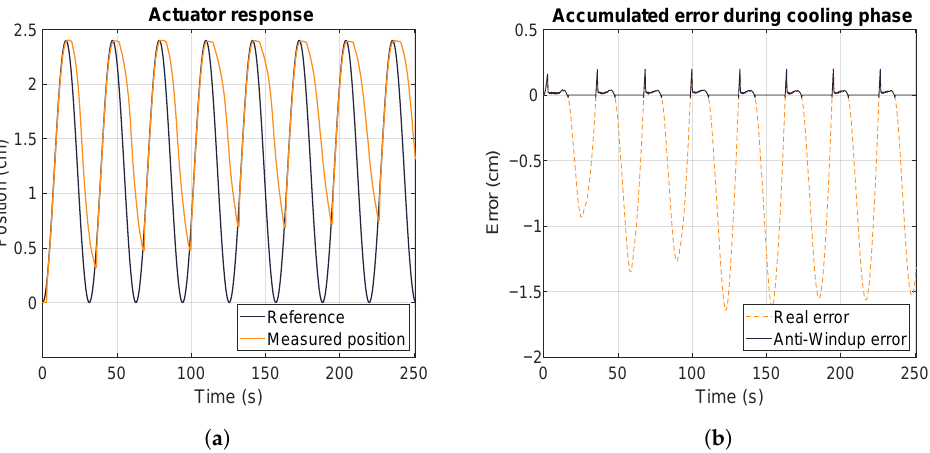
Figure 8. Actuator’s response for a frequency of 0.2 rad/s and a load of 2.00 kg. ( a ) Actuator’s position with respect to reference. ( b ) Actuator’s error signal and anti-windup